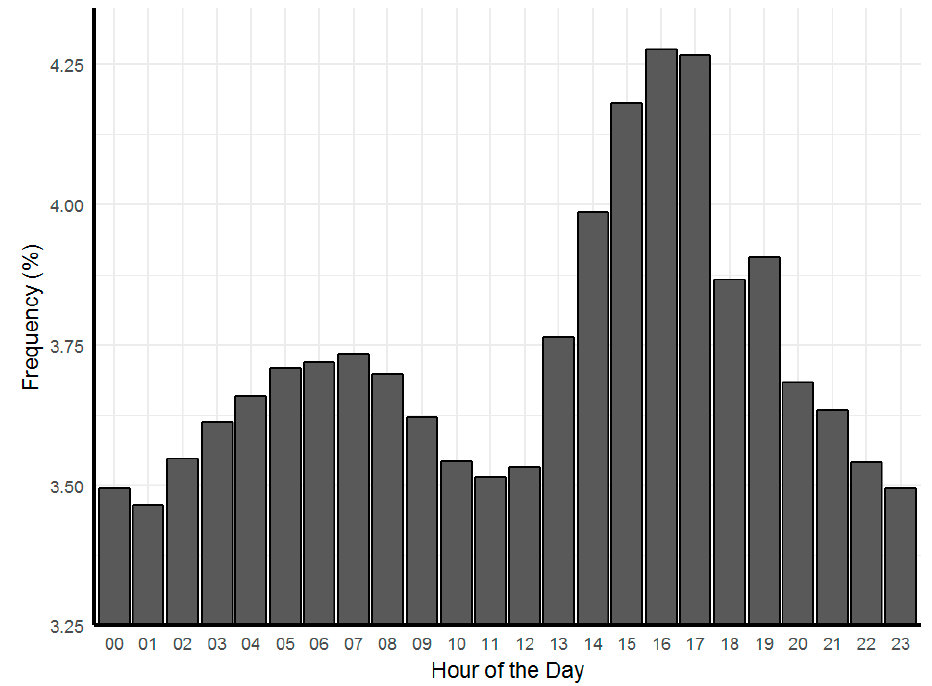
Figure 11. Diurnal distribution of the average precipitation frequency.